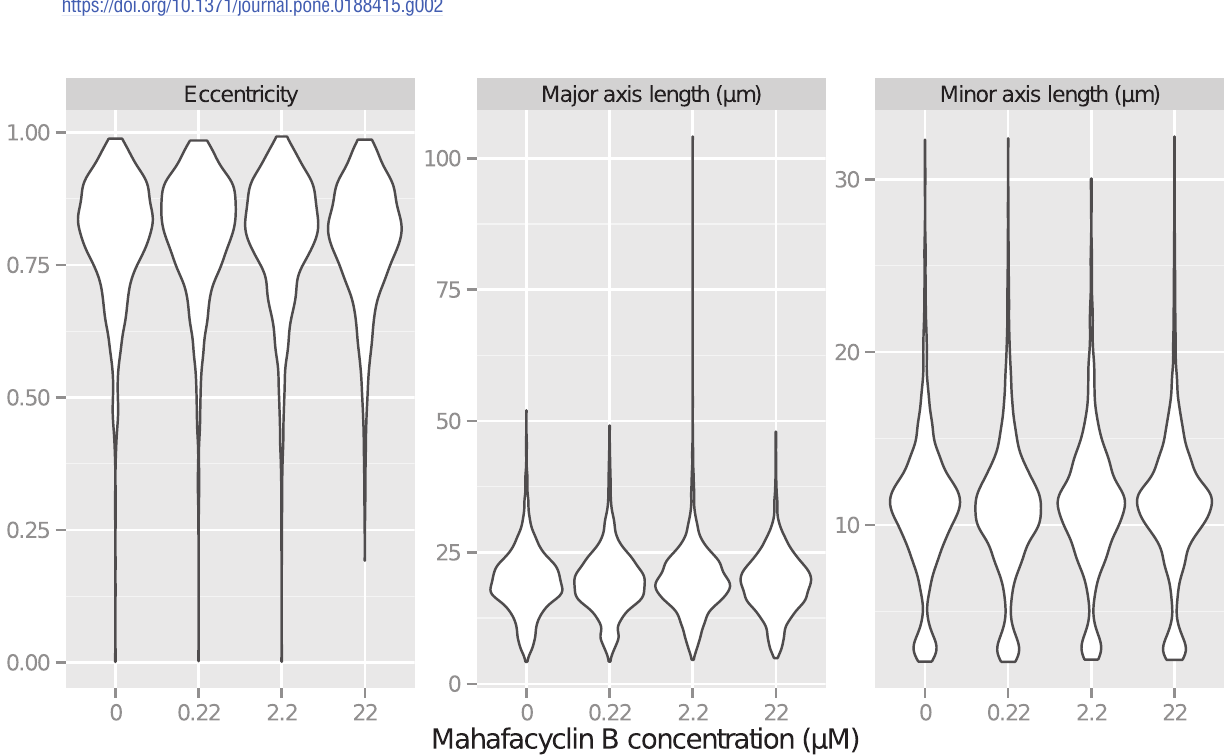
PLOS ONE | https://doi.org/10.1371/journal.pone.0188415 November30,